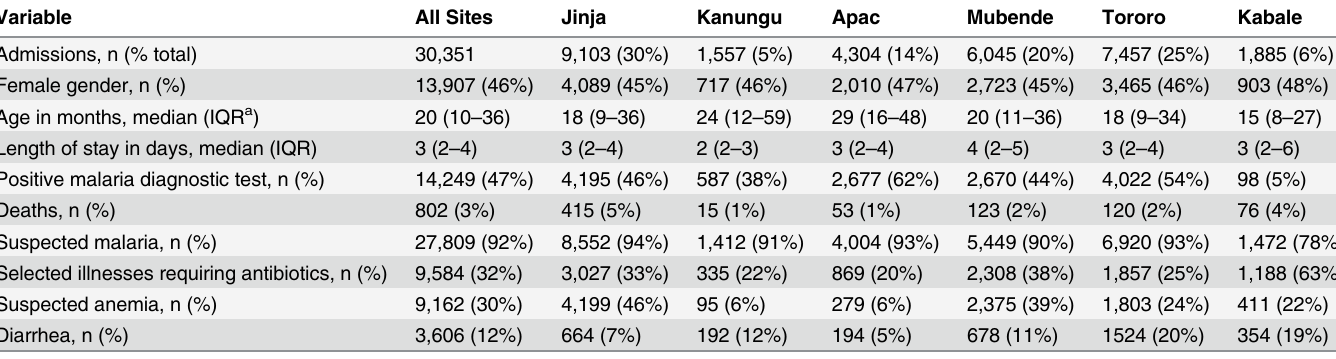
Table 2. Characteristics of pediatric admissions, overall and by health